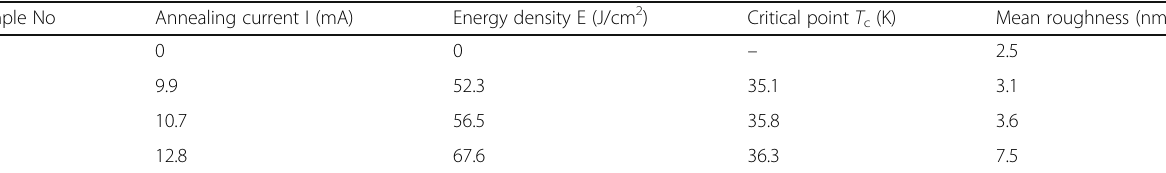
Table 2 Annealing parameters and measured properties of Mg-B thin films